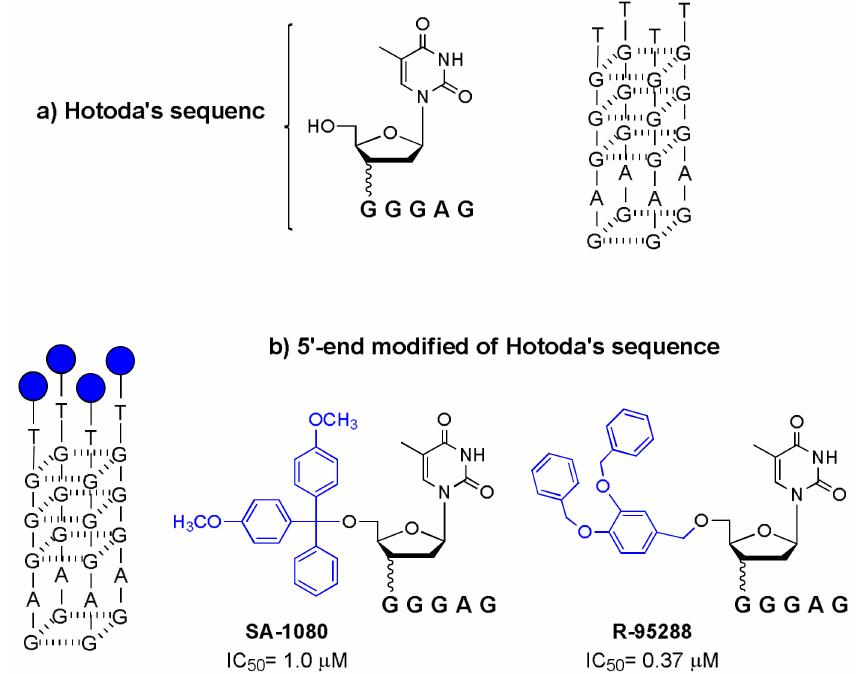
Figure 1. Schematic representation of: ( a ) Hotoda’s sequence; ( b ) its first 5 (cid:48) -end modified sequences with strong anti-HIV activity (IC 50 )